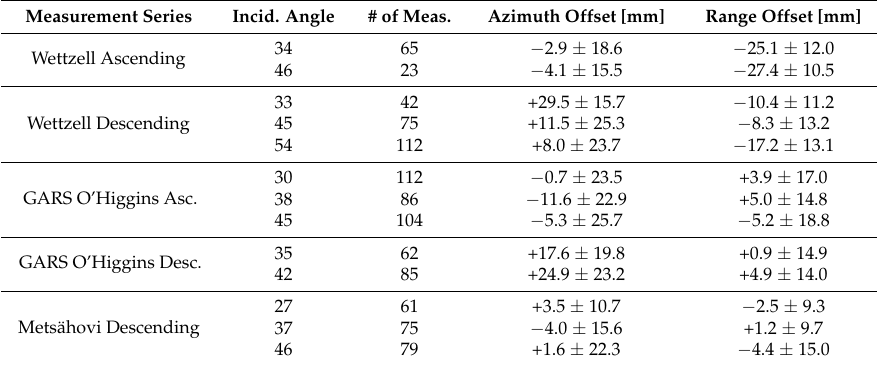
Table 5. Incidence angle wise mean values and standard deviations (1 σ ) of the obtained range and azimuth error.